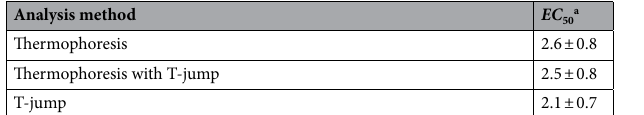
Table 1. Binding characteristics of 7.44 binding to NHR2 from MST experiments. EC 50 was calculated using Eq. (3). a In